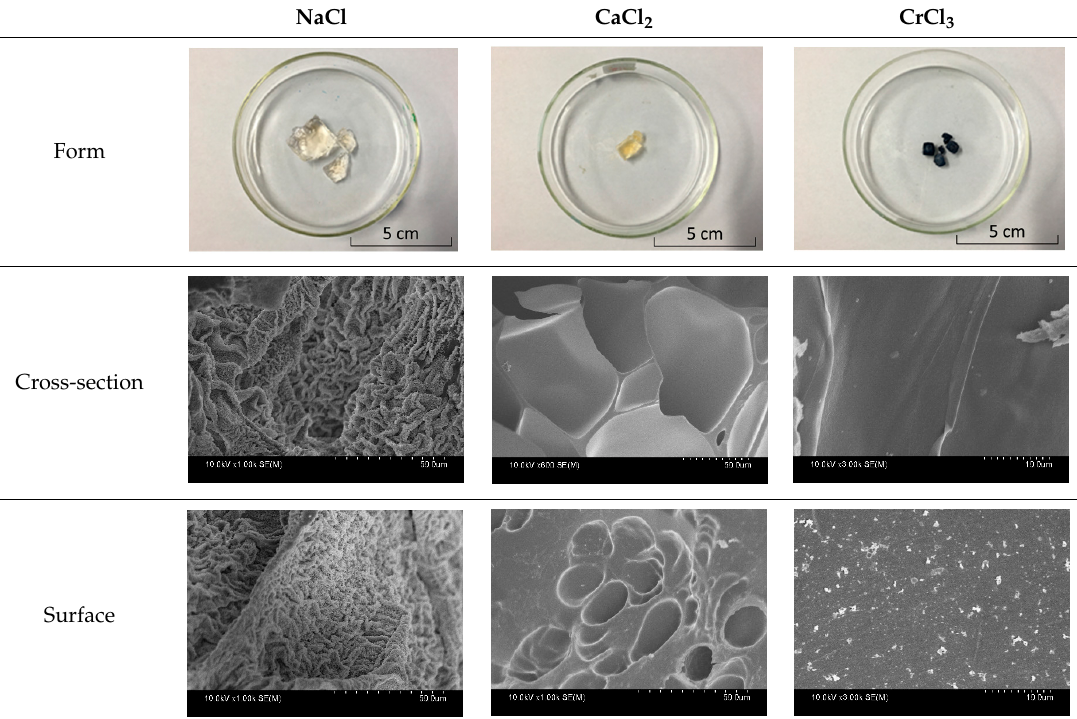
Table 1. The morphology of γ -PGA/ ε -PL hydrogels after swelling equilibrium in 0.1540 mol/L NaCl, CaCl 2 , and CrCl 3 solutions.